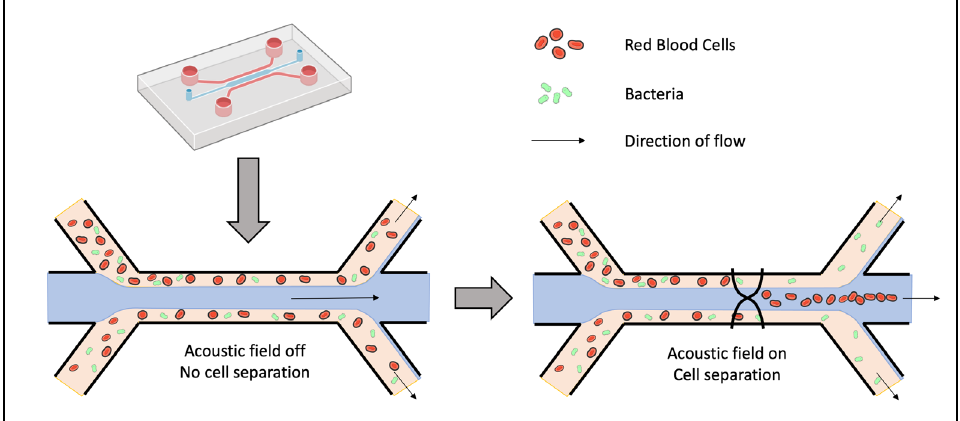
Figure 4. Schematic description of acoustic separation principle. The acoustic field separates blood cells by pushing them in the central stream while bacteria stay in the side streams.